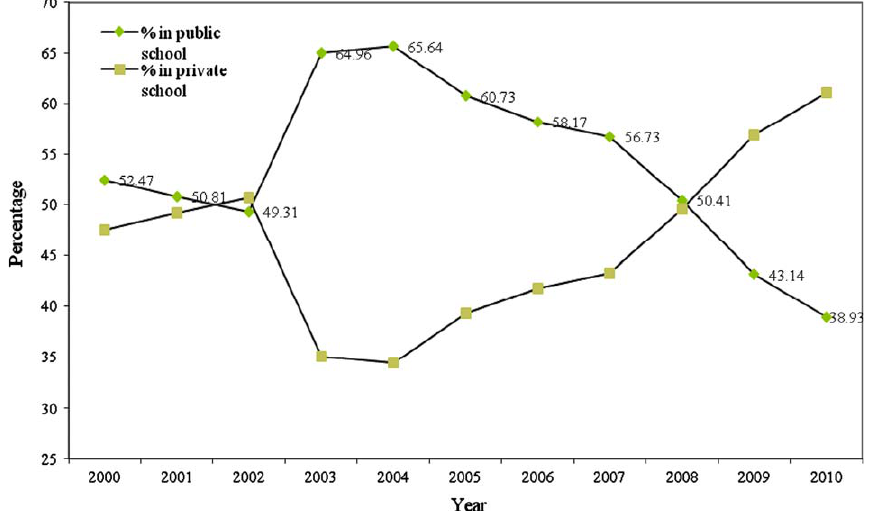
Figure 1. Trends in school enrolment 2000–2010: slums. Source: APHRC, DSS database for Korogocho and Viwandani slums in Nairobi,